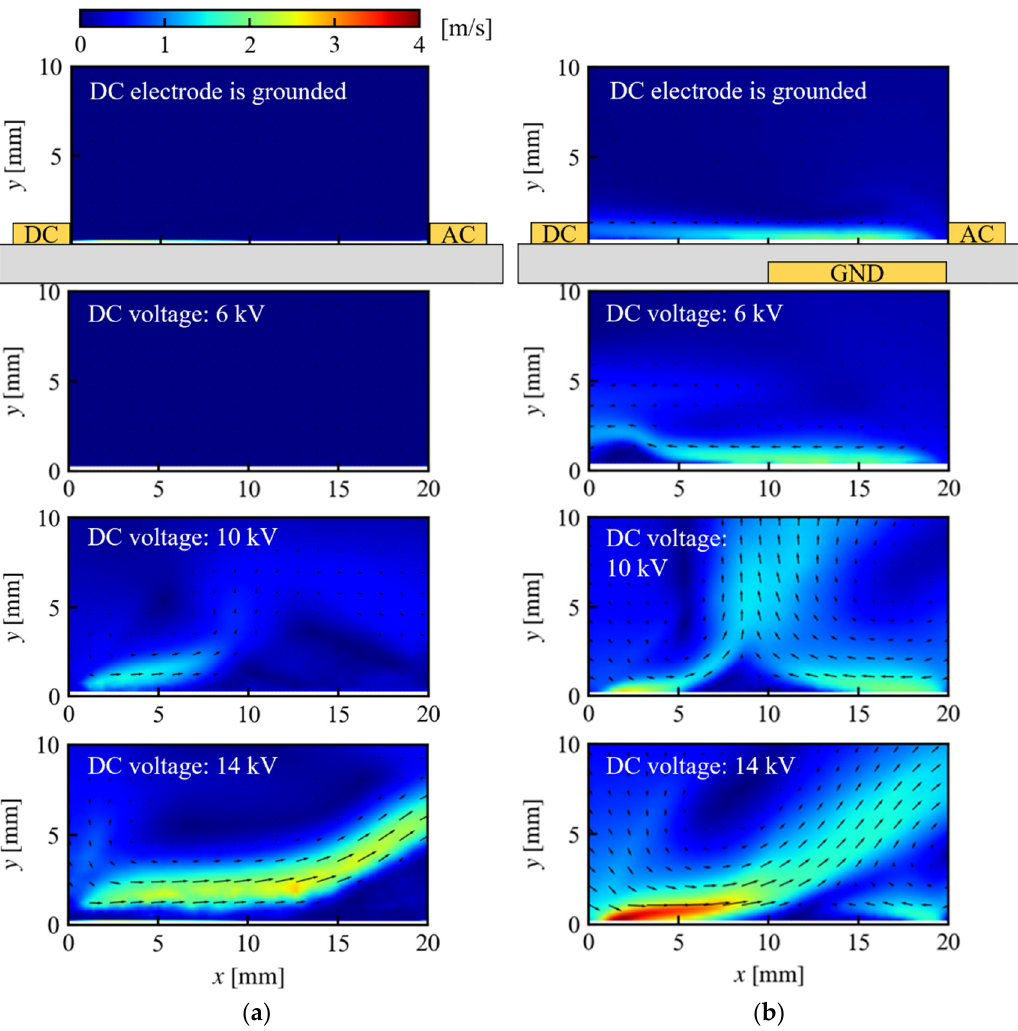
Figure 15. Flow velocity field versus the DC voltage when the AC voltage was 10 kV pp at 4 kHz in the ( a ) CD-PA and ( b ) TED-PA. the ( a ) CD-PA and ( b )